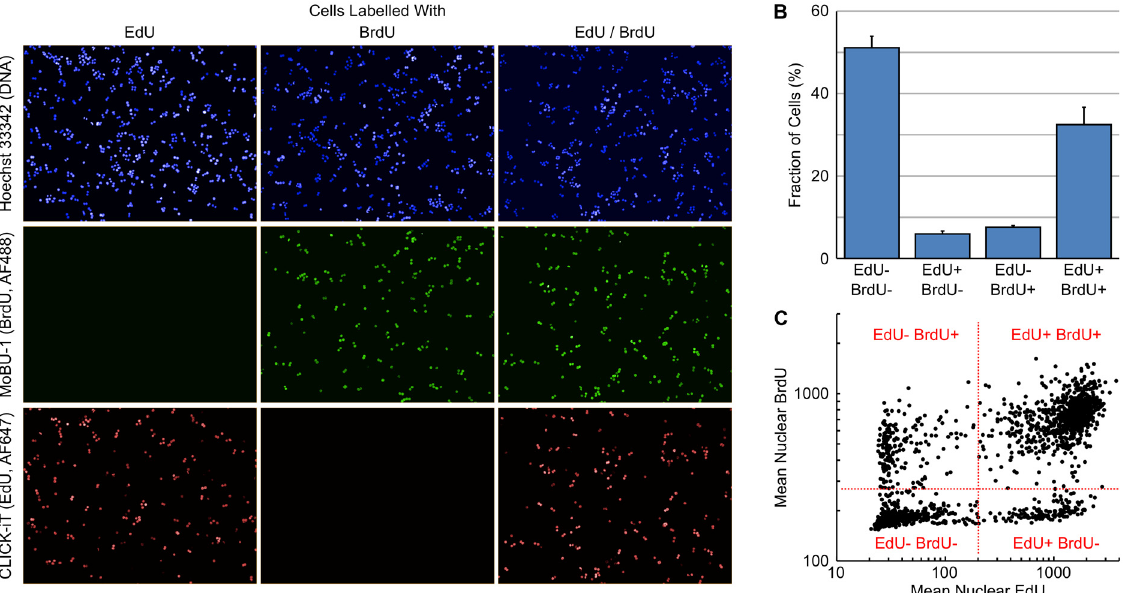
Fig 5. Estimation of S-phase Duration using EdU-BrdU Dual Pulse Labelling. (A) Images of HT29 cells labelled with various combinations of EdU and BrdU demonstrating the selectivity of Click-iT chemistry for EdU and MoBU-1 antibody for BrdU. (B) Percentage of cells labelled with the various combinations of EdU and BrdU. Values are the average of 6 replicates ± SD. (C) Dot plot of Mean Nuclear EdU versus Mean Nuclear BrdU demonstrating the positioning of gates for the various cell populations.